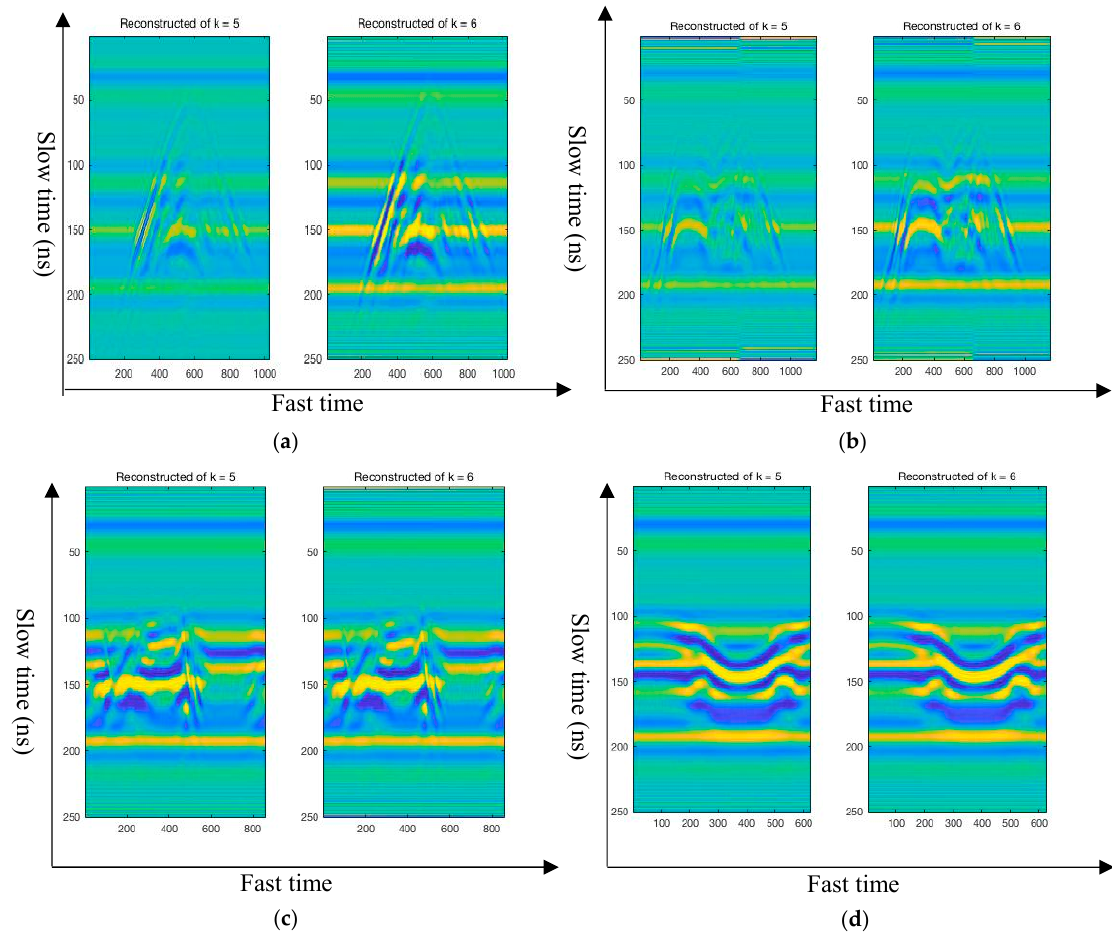
Figure 10. Reconstruction of 2D human motion echo analysis signals of four di ff erent types of carrier-free UWB radar. (The figure on the left shows the reconstruction of 2D echo signal of human motion of the carrier-free UWB radar through 2D-VMD algorithm when k = 5, and the figure on the right shows the reconstruction of 2D echo signal of human motion of carrier-free UWB radar through 2D-VMD algorithm when k = 6.) ( a ) Reconstruction of 2D human motion echo analysis signal of walk forward of carrier-free UWB radar. ( b ) Reconstruction of 2D human motion echo analysis signal of fall forward of carrier-free UWB radar. ( c ) Reconstruction of 2D human motion echo analysis of walk around of carrier-free UWB radar. ( d ) Reconstruction of 2D human motion echo analysis signal.